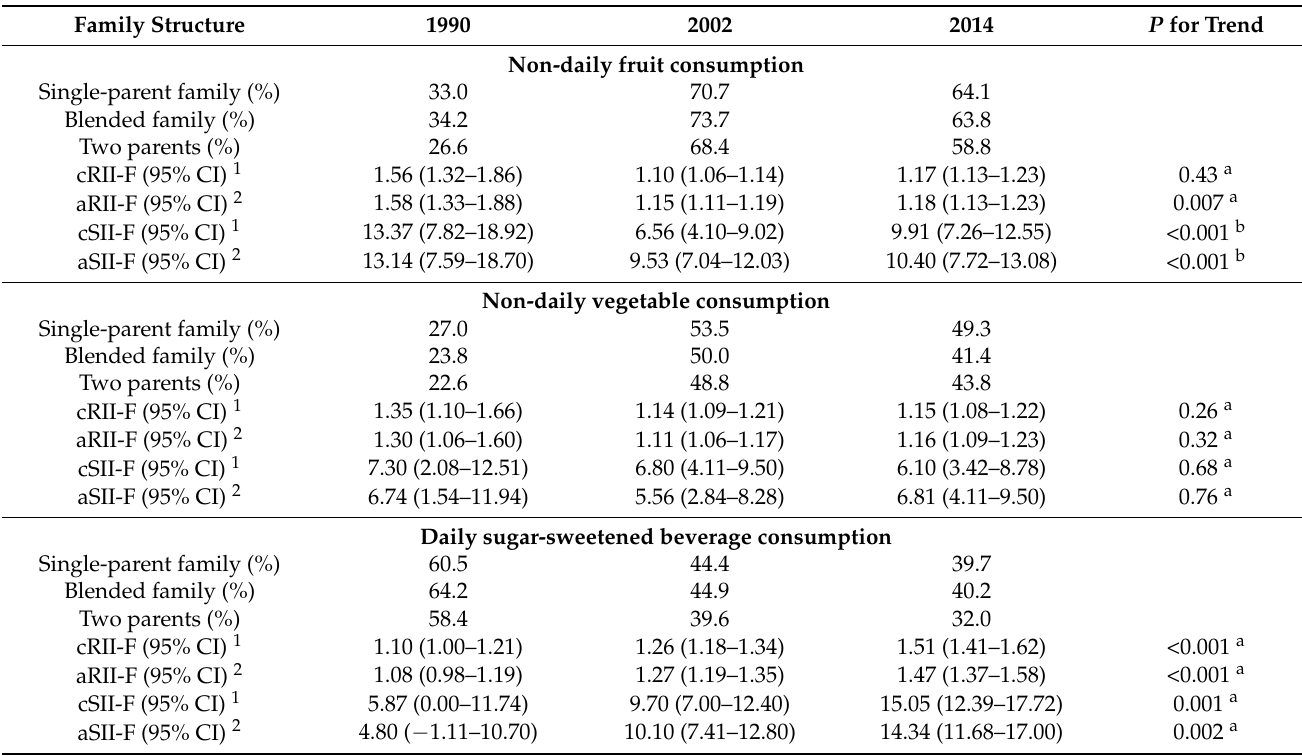
Table 1. Prevalence and Relative Index and Slope Index of Family Inequalities (RII-F and SII-F) of fruit, vegetable and sugar-sweetened beverage consumption among adolescents between 1990 and 2014 (HBSC, Belgium,